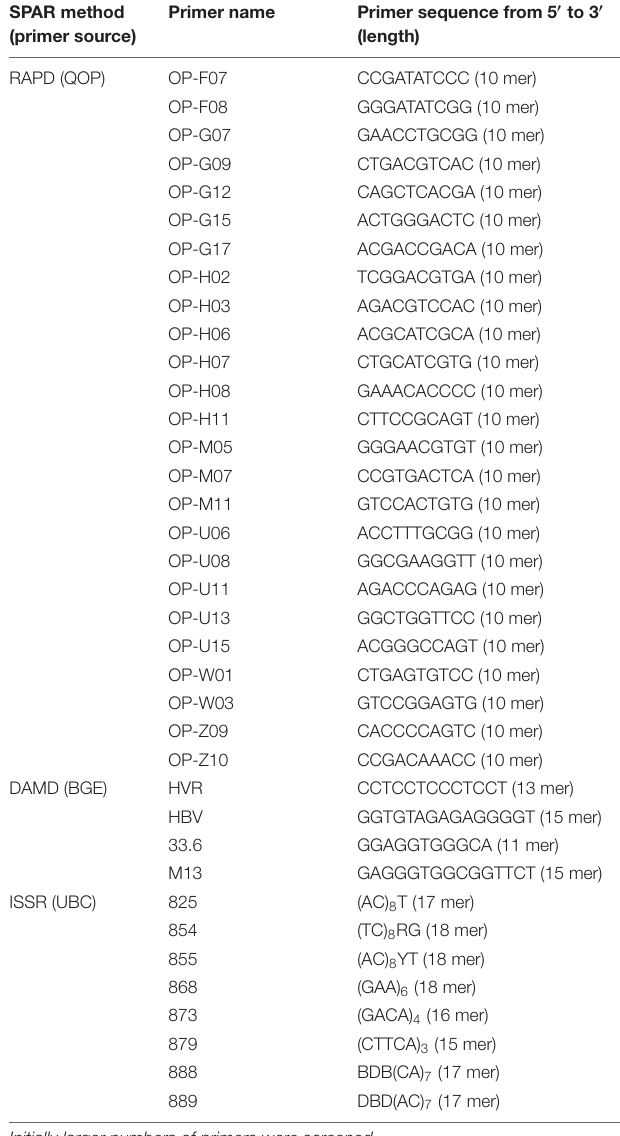
TABLE 2 | List of primers used for all PCR based profiling